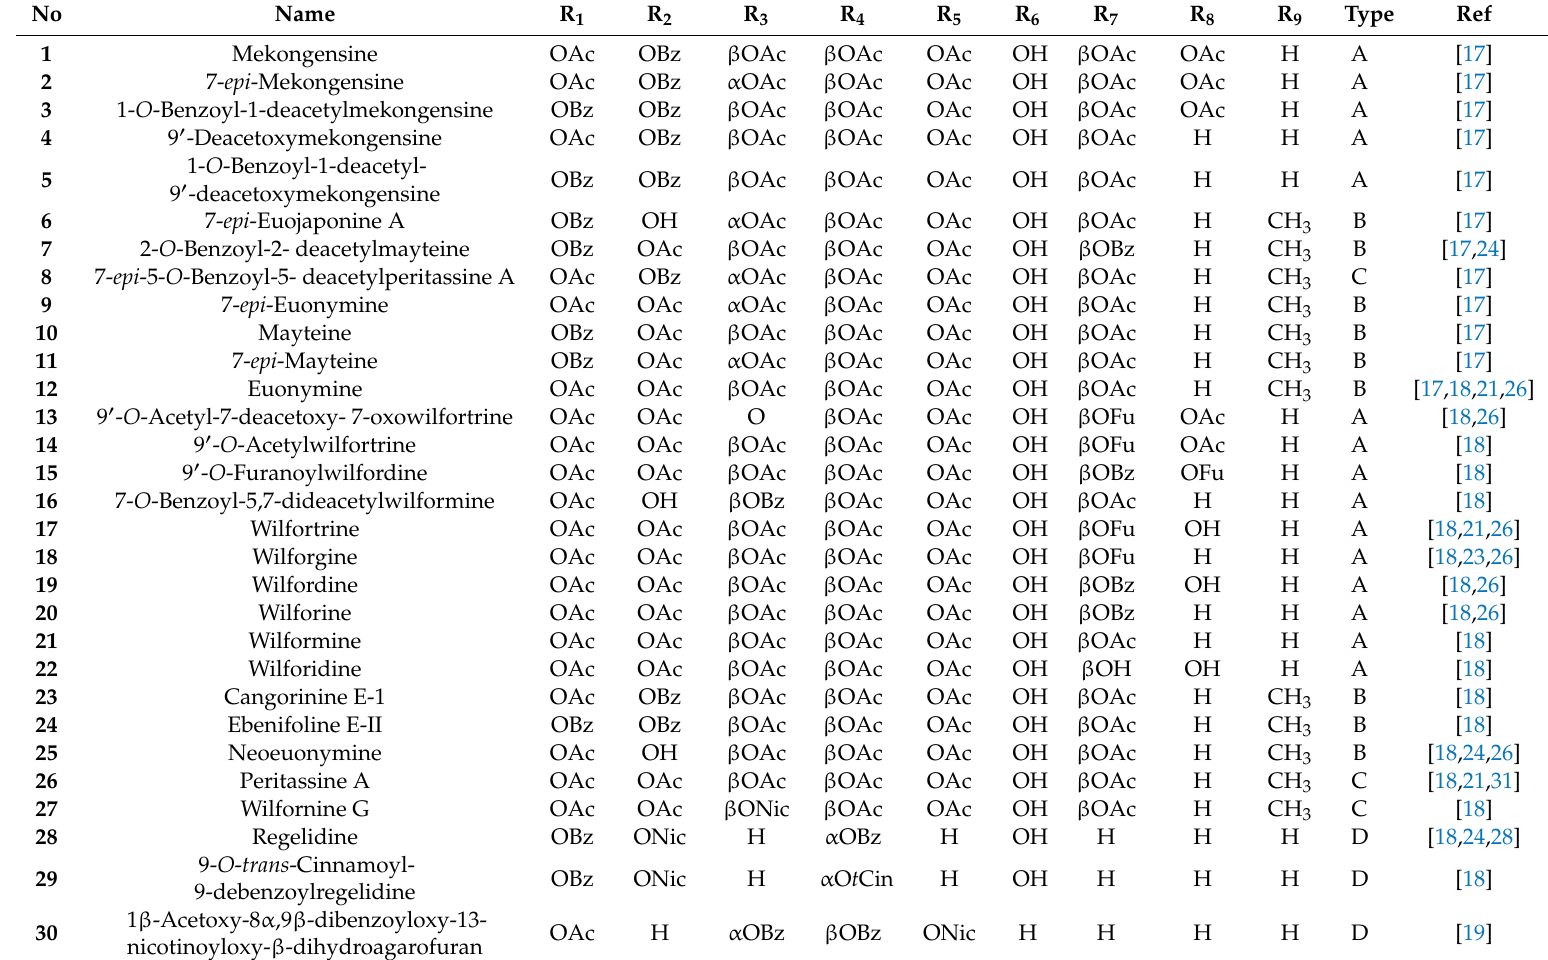
Table 1. Reported structures ofdihydroagarofuran sesquiterpenoids 1 – 144